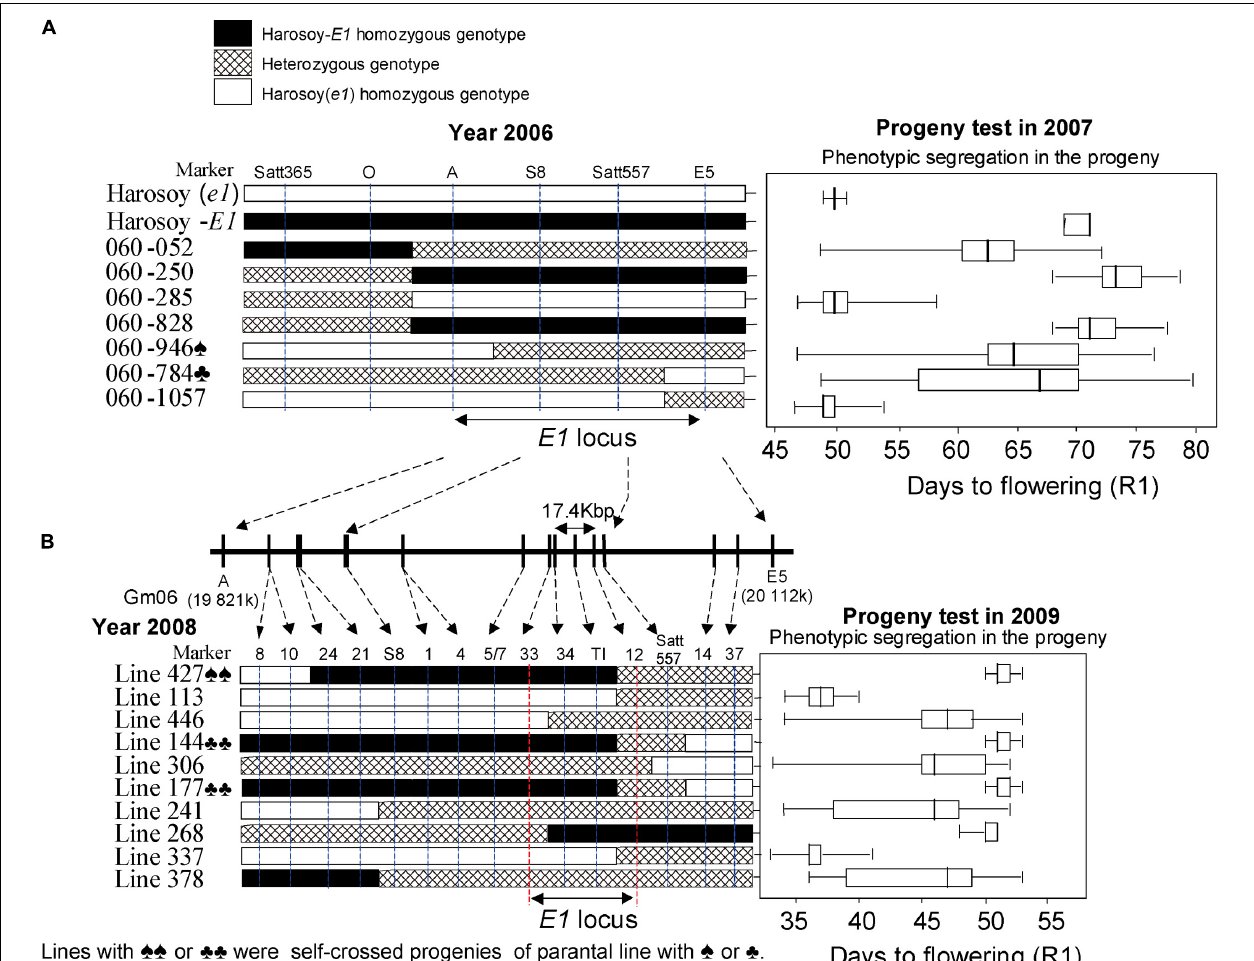
FIGURE 6 | Fine mapping of the E1 gene. Graphical genotypes of soybean recombinants carrying recombination in the E1 region in the 2006–2009 experiments. Left: Recombinants detected. Right: Phenotypic segregation patterns in the progenies. Recombination is shown by white bars representing Harosoy ( e1 ), black bars representing Harosoy- E1 , and cross-hatched bars representing the heterozygote. The phenotypic segregation is presented in boxplot format. The box, the bold vertical line, and the horizontal line, respectively represent the interquartile region, median, and range of flowering time. In 2006–2007 (A) , with seven recombinants, we were able to delimit the E1 to a 289-kb region. In 2008–2009 (B) , with 10 recombinants, we further delimited the E1 region to a 17.4-kb region (adapted from Xia et al.,